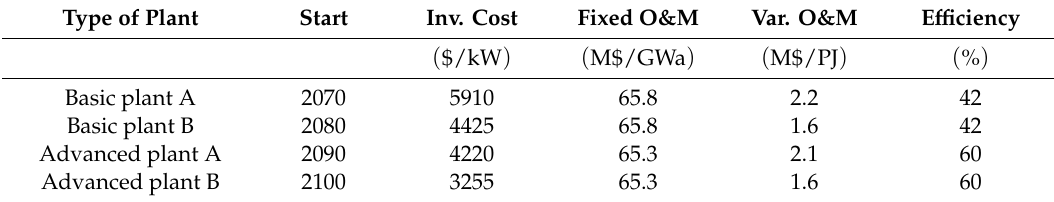
Table 10. Data adopted in the current analysis for the fusion technologies